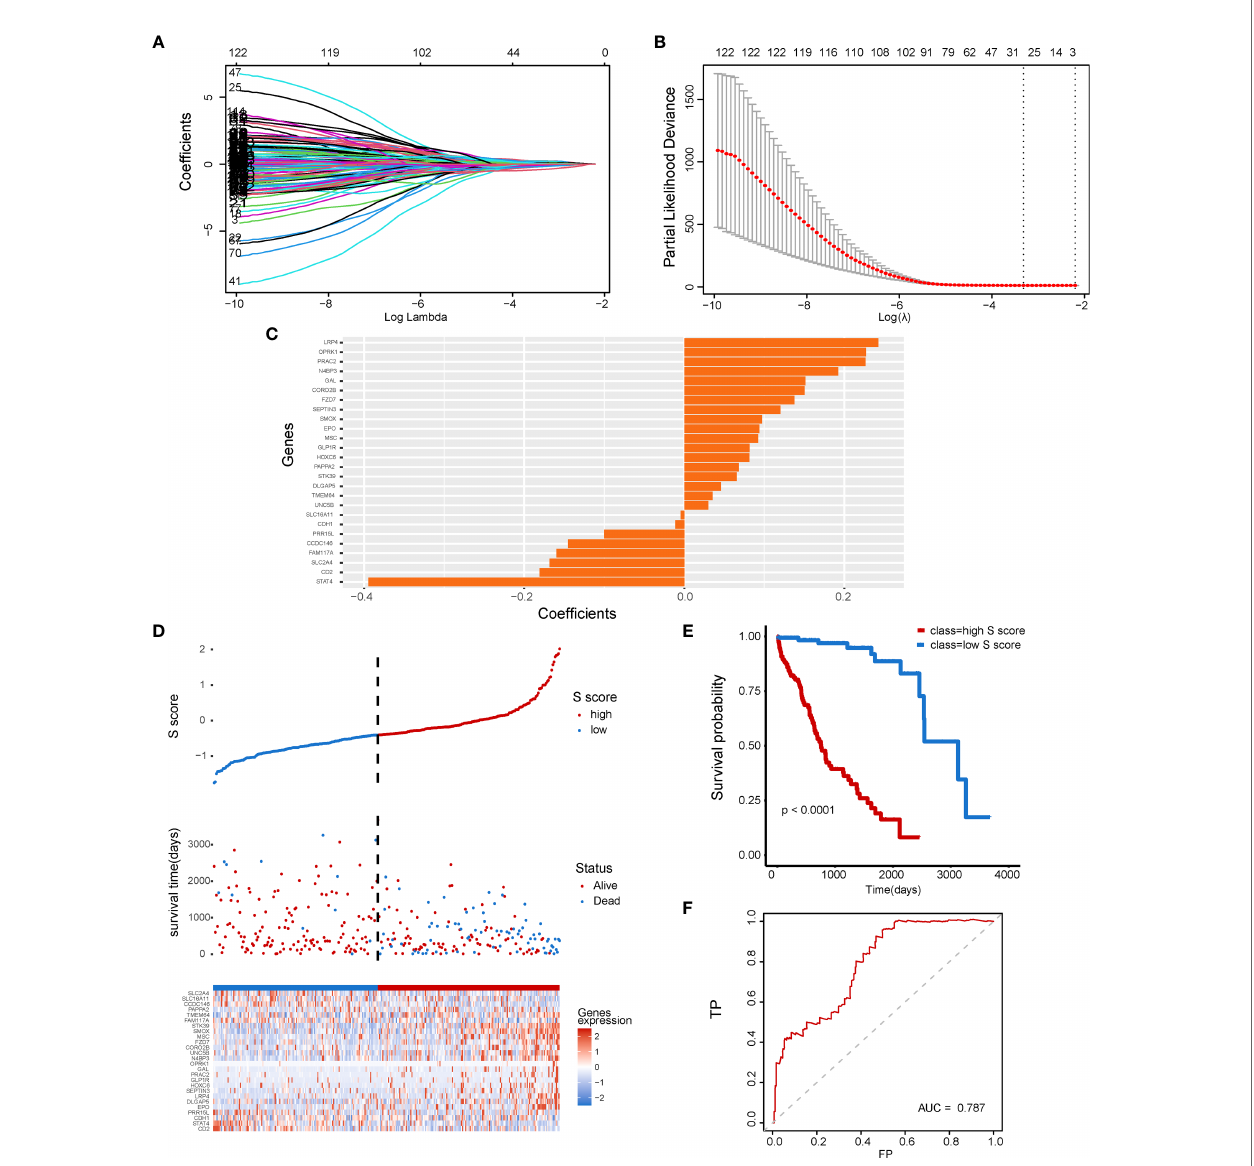
FIGURE 4 | Construction of a senescence-related prognostic model for HCC. (A) The coef fi cients of genes calculated by multivariate Cox regression using LASSO. (B) The partial likelihood deviance of genes. (C) The coef fi cients of selected genes. (D) S score distribution for patients in the TCGA-LIHC database. (E, F) Comparison of patient ’ s prognosis in high – S score group and low – S score